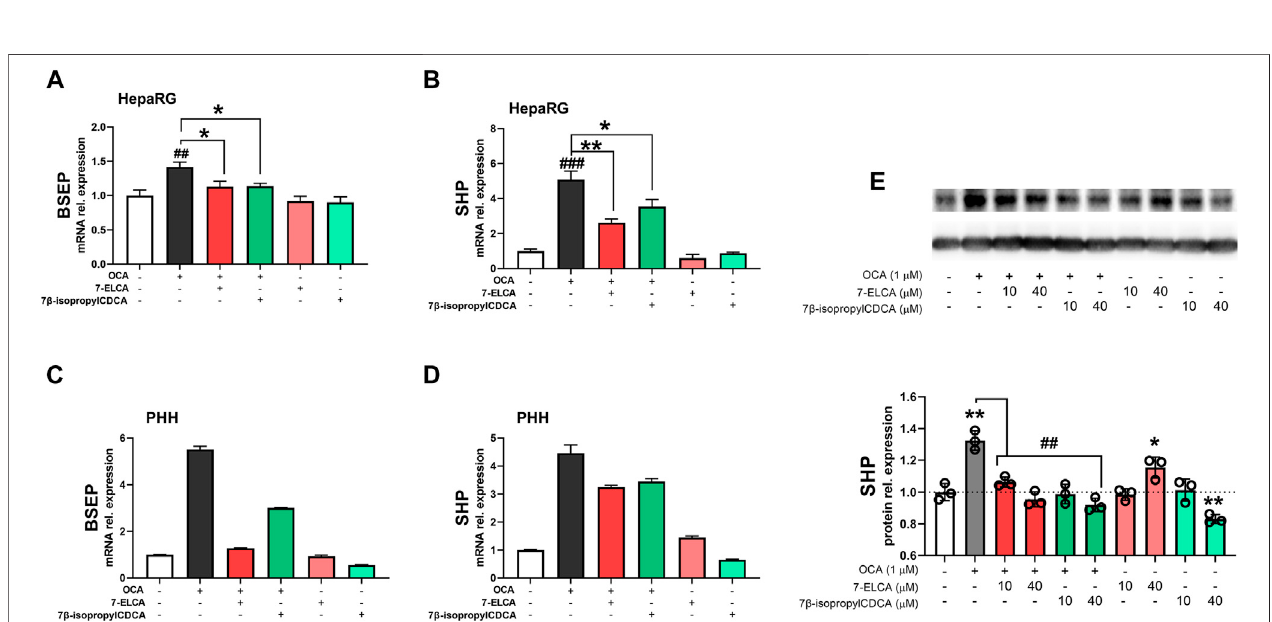
FIGURE6| RegulationofFXRdownstreamgenesby7-ELCAand7 β -propyl-CDCAinthepresenceorabsenceof1 µMOCAasthepotentFXRagonist.Real-time qPCR analysis of mRNA expression of (A,C) BSEP and (B,D) SHP genes was performed in terminally differentiated HepaRG hepatic cells (A,B) , and in primary human hepatocytes (PHH) from one donor treated for 24 h (C,D) . (E) SHP protein expression in HepaRG cells after 48 h treatment with OCA alone or in combination with 7- ELCA and 7 β -propyl-CDCA. Data were normalized to B2M mRNA or GAPDH protein and are expressed relative to those of control (vehicle-treated) cells. The experiments wererepeated inthreeindependentexperimentsperformedintriplicatesand valuesarepresentedasthemeans ± SD. ** p < 0.01,*** p < 0.001vs. NT; # p < 0.05, ## p < 0.01 vs. 1 µM OCA.